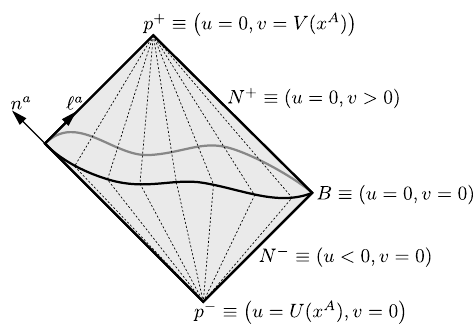
Figure 1 . Diagram of a causal diamond in a spacetime ( M; g ). The points p (cid:6) denote the corners of the causal diamond and B is the bifurcation edge while N (cid:6) denote the future/past null surfaces joining B to p (cid:6) , respectively. The functions v and u are a(cid:14)ne coordinates with a(cid:14)ne null normals ‘ a and n a on N (cid:6)